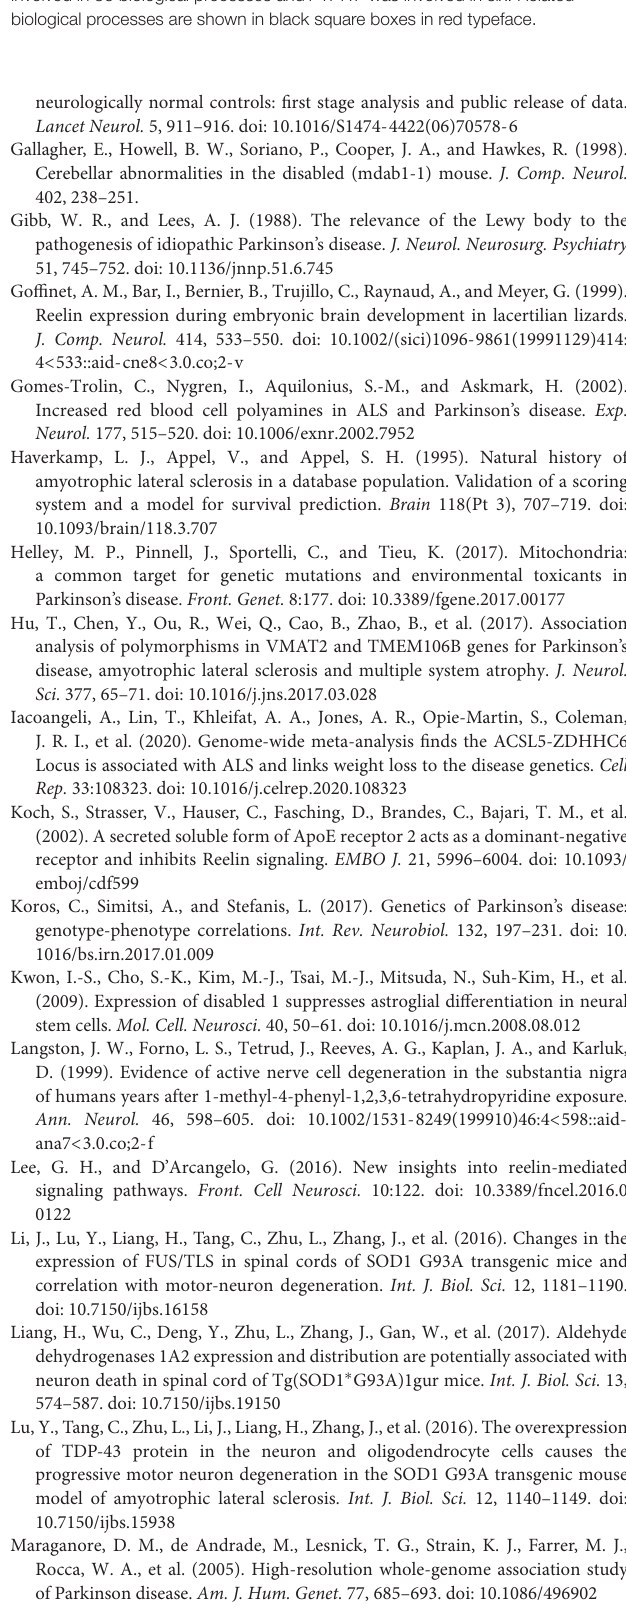
Supplementary Figure 1 | GO analysis of ten candidate genes. Ten candidate genes involved in 40 significantly correlated biological processes. DAB1 was